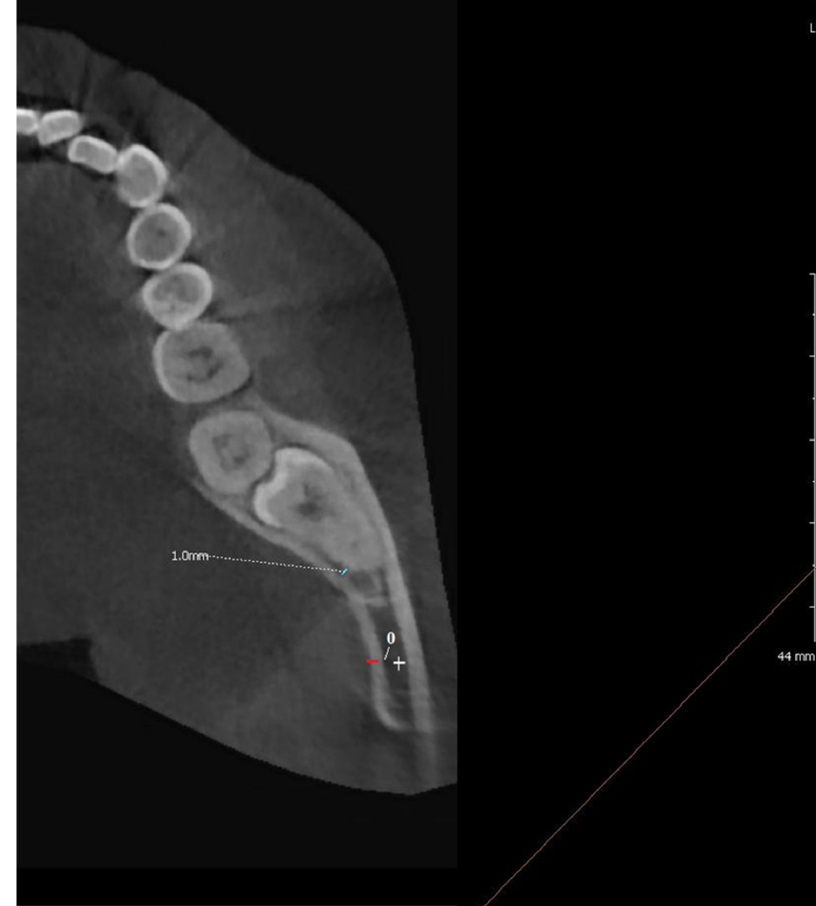
Figure 1. The distance is directly proportional to the root position. If the root is distant from the lingual cortical bone the measurement is considered positive when the root is in contact with the cortical lingual bone the distance is 0 and into the lingual cortical bone, the distance is negative. As reported in the figure the landmark for zero value is the buccal portion of the lingual cortical bone. The distance in the trabecular bone is positive (white) and the distance into the cortical bone is negative (red). The distance for this third molar is 1 mm (green).